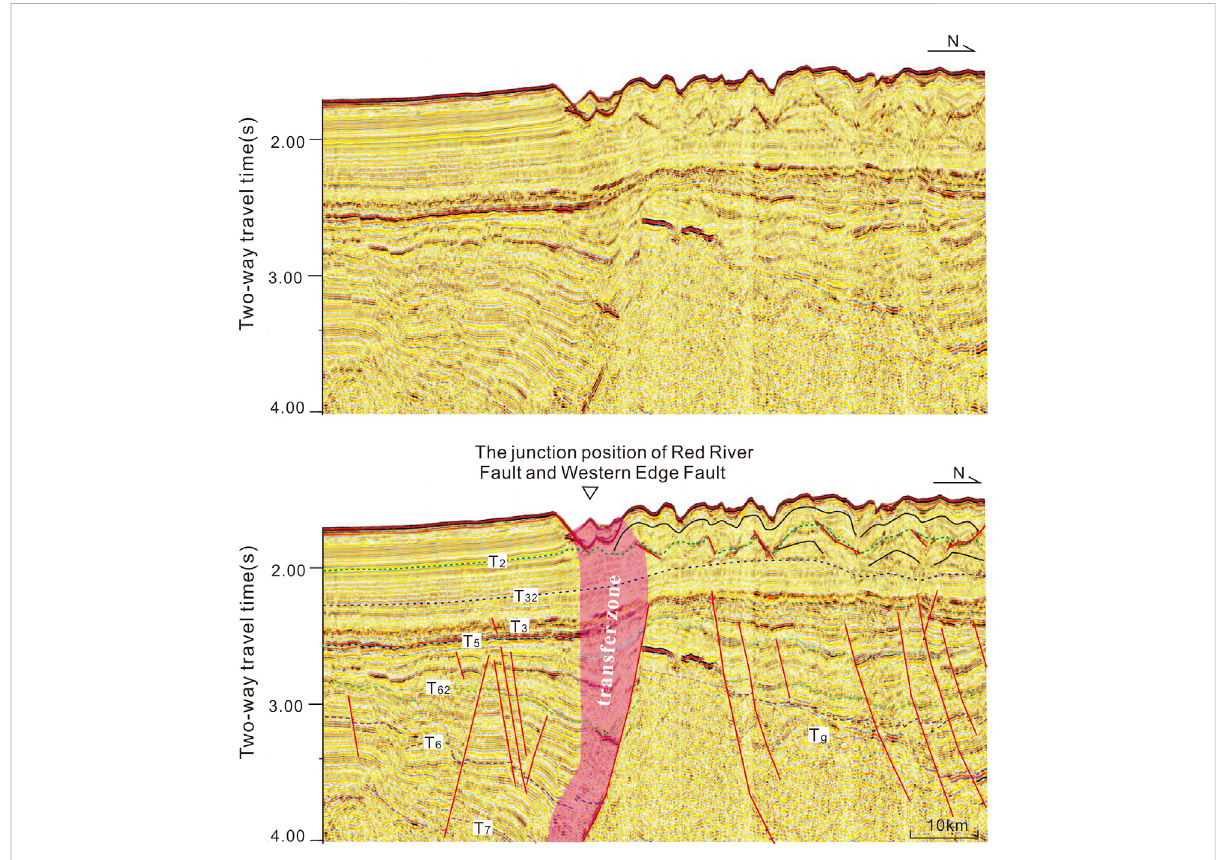
FIGURE 6 The junction position of RRF and WEFSCS in seismic section. The position of pro fi le can be seen survey line A6 in Figure